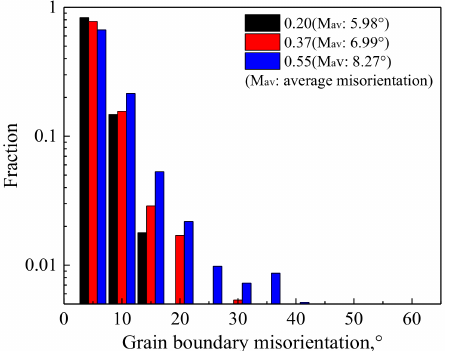
Figure 11. Misorientation distribution of grain boundaries in the interiors of all the original deformed grains (not including original high-angle grain boundaries) after deformation at Z = 3.69 × 10 23 to different